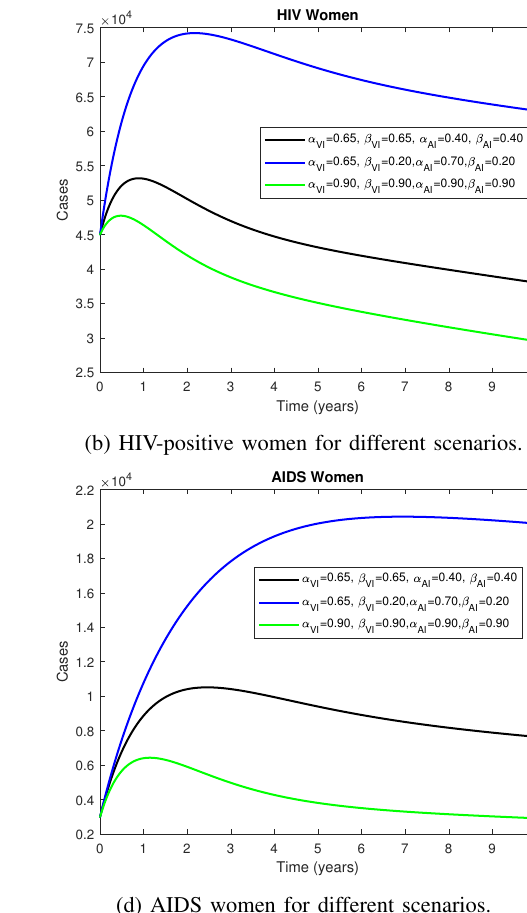
VI =0.90, VI =0.90, AI =0.90, AI =0.90